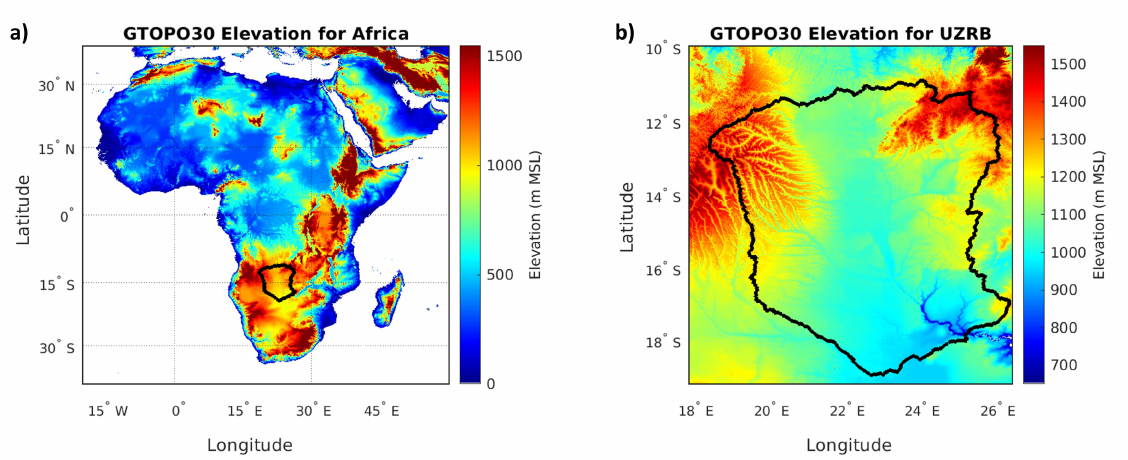
Figure 1. Digital elevation map of ( a ) Africa and ( b ) the Upper Zambezi River Basin (UZRB) with the UZRB outlined in black. MSL, Mean Sea Level. Note the different elevation scales on the left (0 to 1550 m MSL) and on the right (650 to 1550 m MSL).